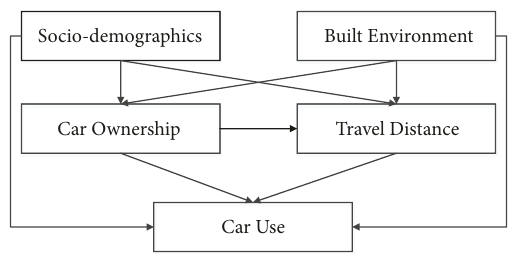
Figure 3: Potential relationship between built environment and travel